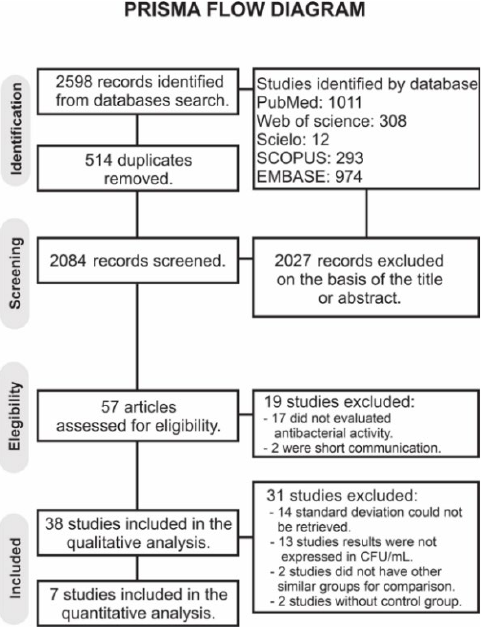
Figure 1. Search flowchart according to the PRISMA Statement.